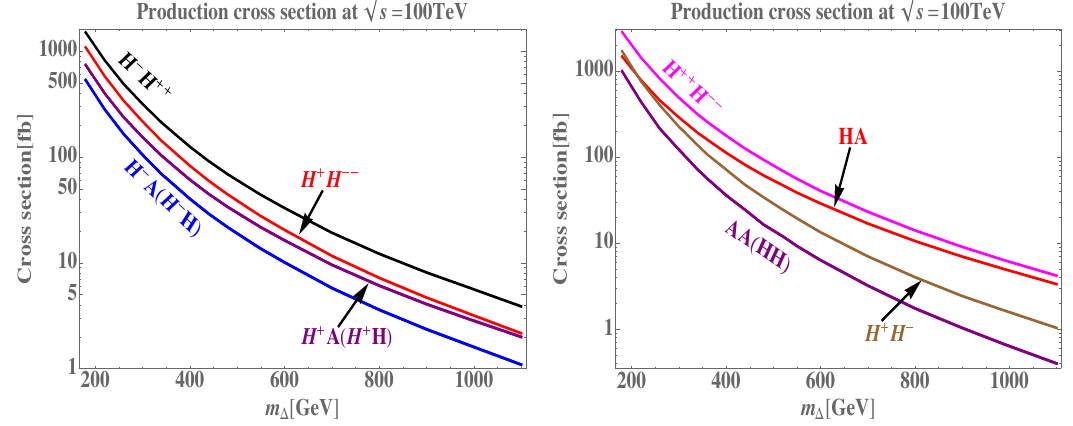
p Figure 3 . Production cross section as a function of m (cid:1) at s = 100 TeV with v (cid:1) = 10 (cid:0) 3 GeV. We set (cid:21) 2 = 0 : 2, (cid:21) 3 = 0, (cid:21) 4 = 0 and (cid:21) 5 = (cid:0) 0 : 1, which correspond to the black dot in the left panel of (cid:12)gure 1 in order to be consistent with the NMH framework and to satisfy the model constraints discussed in section 2.2.2. The left panel is for associated Higgs production channels while the right one is for pair production except the HA channel. Since the production cross section of HA is very close to H (cid:0) H ++ , we include it in the right panel to make the plots more